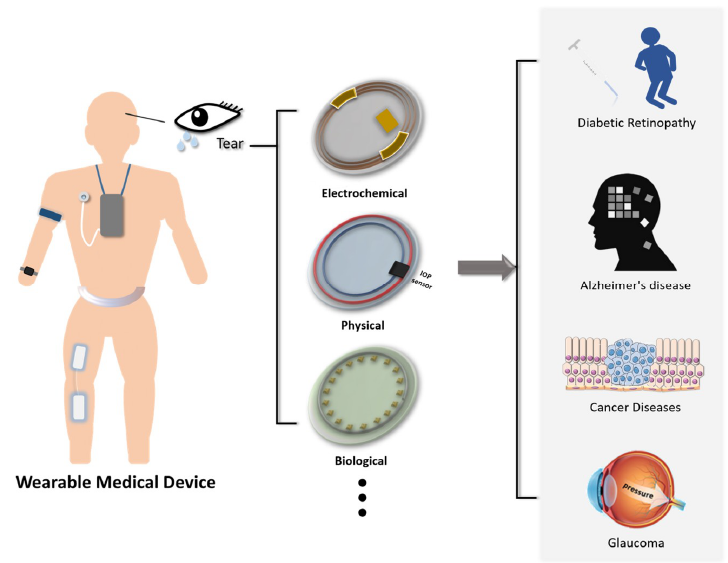
Figure 1. Overview of tear‐based wearable medical devices.